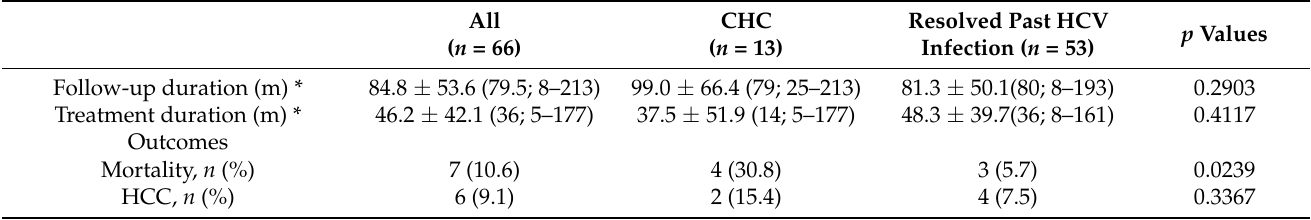
Table 3. Follow-up/treatment durations and outcomes of the enrolled